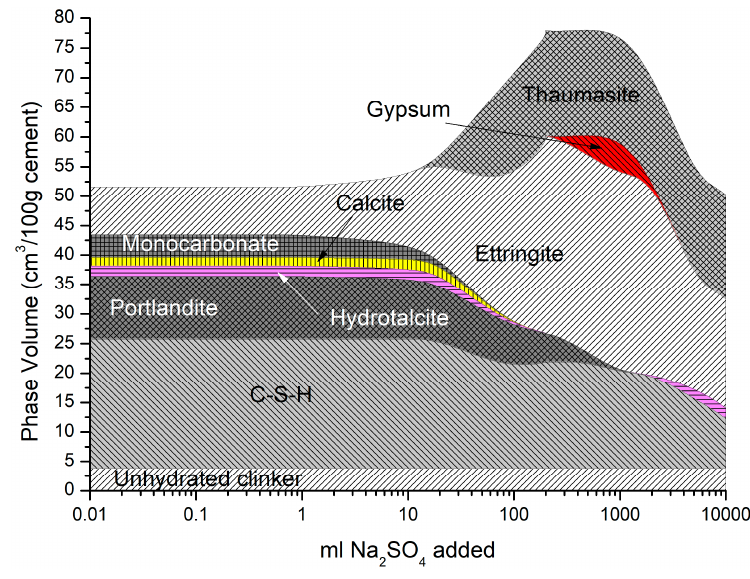
Figure 6. Phase assemblage with increasing sodium sulfate concentration.